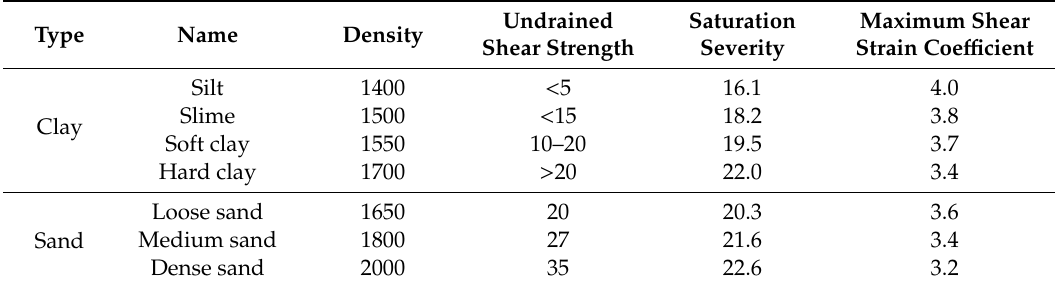
Table 2. Physical parameters used in the